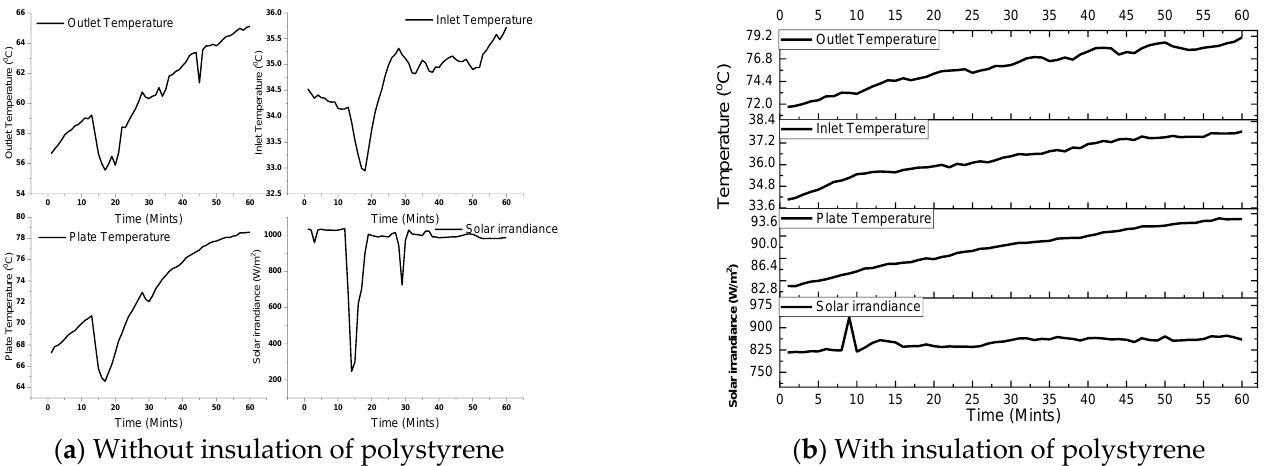
( b ) With insulation of polystyrene Figure 10. Graphical representation of different points temperatures and solar irradiance for para- metric study of the solar air heater at mass flow rate of 0.005 kg·s −1 . The final experiment was conducted in the courtyard of the School of Chemical and Biomolecular Engineering the University of Sydney, Australia (33.8905° S, 151.1929° E). The solar air heater was used as a pre-heater providing an outlet air temperature of 73 °C with a humid enthalpy of 164 kJ·kg −1 . The mass flow rate was 0.01 kg·s −1 The ambient temperature measured was 31 °C. The energy flow rate into the electrical heater was 0.327 kW in the experiment using the solar air heater. Figure 11 shows the inlet temperature, the outlet temperature, the plate temperature, and the solar irradiance for the final experiment using a the solar-assisted spray drying system. The inlet temperature shows a steady value, while the plate and outlet temperatures dropped in the initial 5 min then reached relatively steady state conditions. The average outlet temperature under steady state conditions was measured to be 73 °C. A greater difference between the inlet and outlet air temperatures indicates the good efficiency of the solar air heater. The lower difference between the plate temperature and the outlet temperature indicated a good heat transfer rate. On the right y-axis, the solar irradiance was seen to rise, and fall. According to international standards, for a solar based experiment to be considered valid, the solar irradiance value cannot be increased or decreased by more than 100 W·m −2 over a ten minute time interval, and a solar irradiance value lower than 450 W·m −2 or greater than 1100 W·m −2 also render the experiment invalid. In addition, the experiment for performance evaluation must be conducted between 10.00 to 14.00 solar time for the experiment to be considered valid [36]. These validity requirements were all met in these experiments. The Graphical representation of the below experiment for one hour is shown in Figure 12.